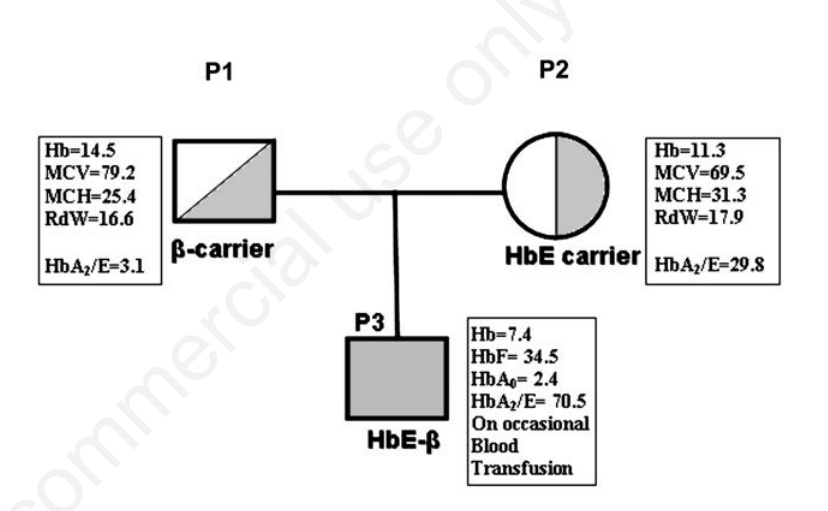
(HbA ) value (3.1%). MCV, mean cell vol- 2 2